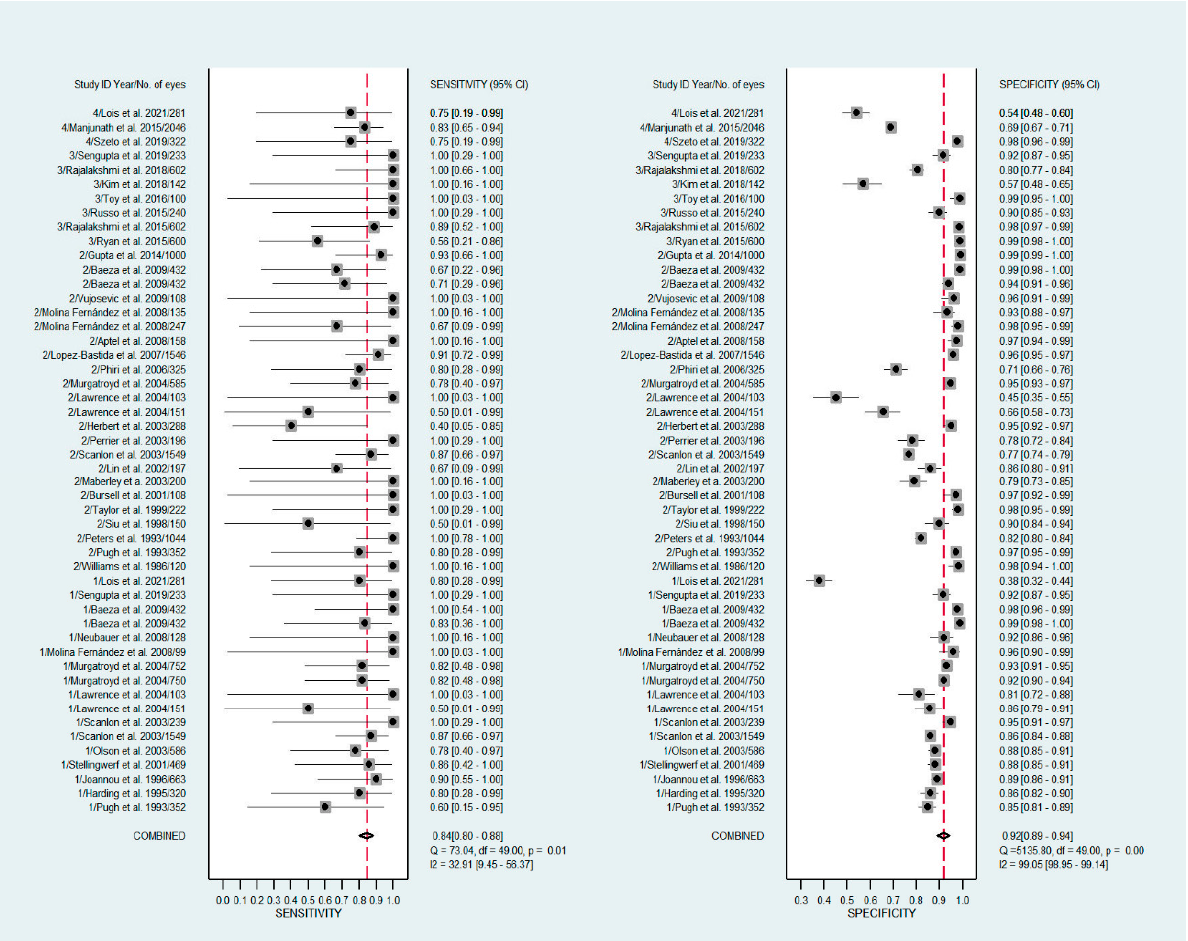
Figure 2. Forest plots for the sensitivity and specificity of mydriatic, non-mydriatic and smartphone-based fundus imaging.